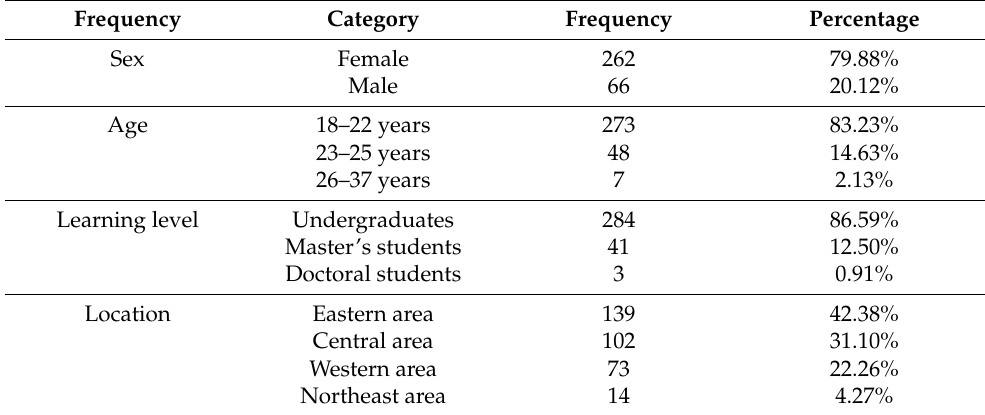
Table 2. Basic characteristics of